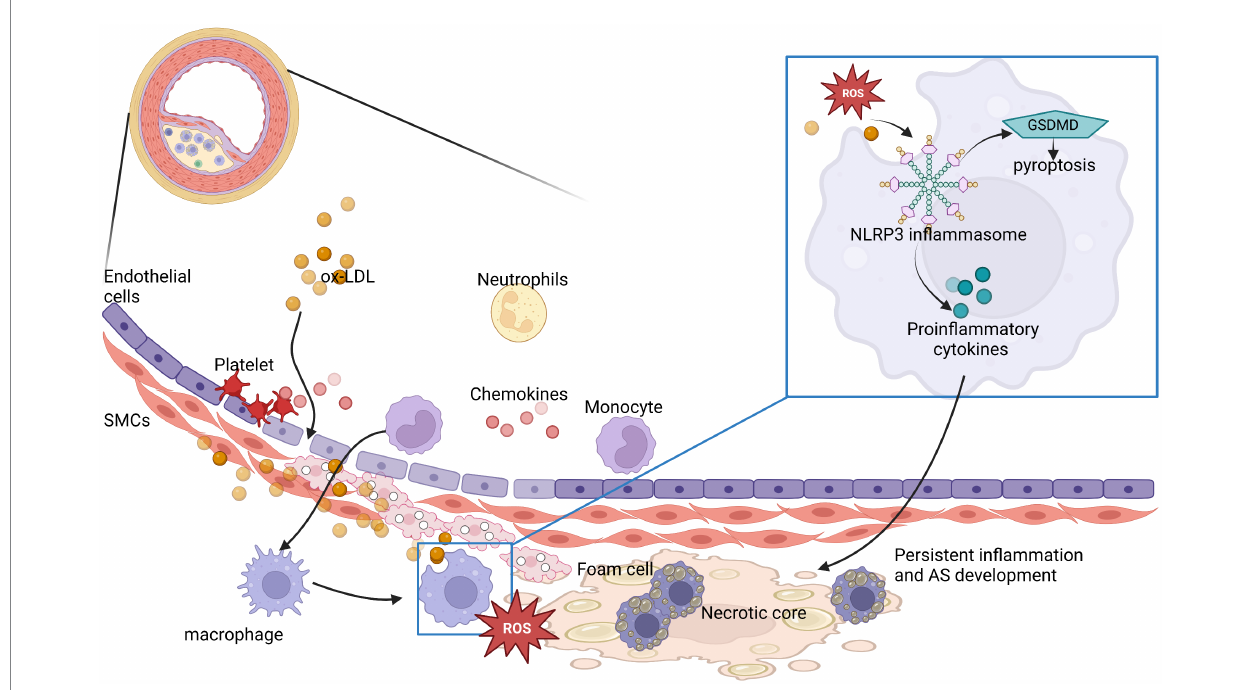
FIGURE 1 NLRP3 inflammasomes participate in and play an amplifying role in the development of atherosclerotic inflammation. The process is represented by ox-LDL in the Figure 1. ROS, reactive oxygen species; AS,